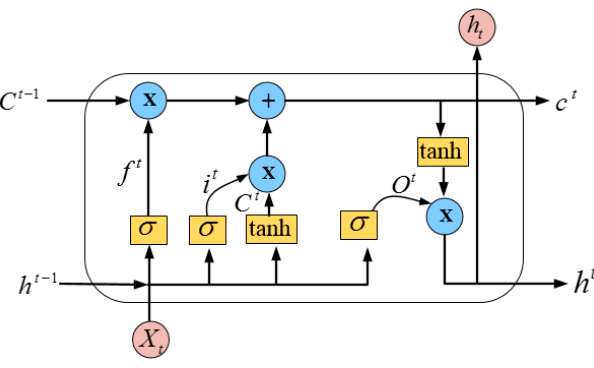
Figure 6. LSTM unit.